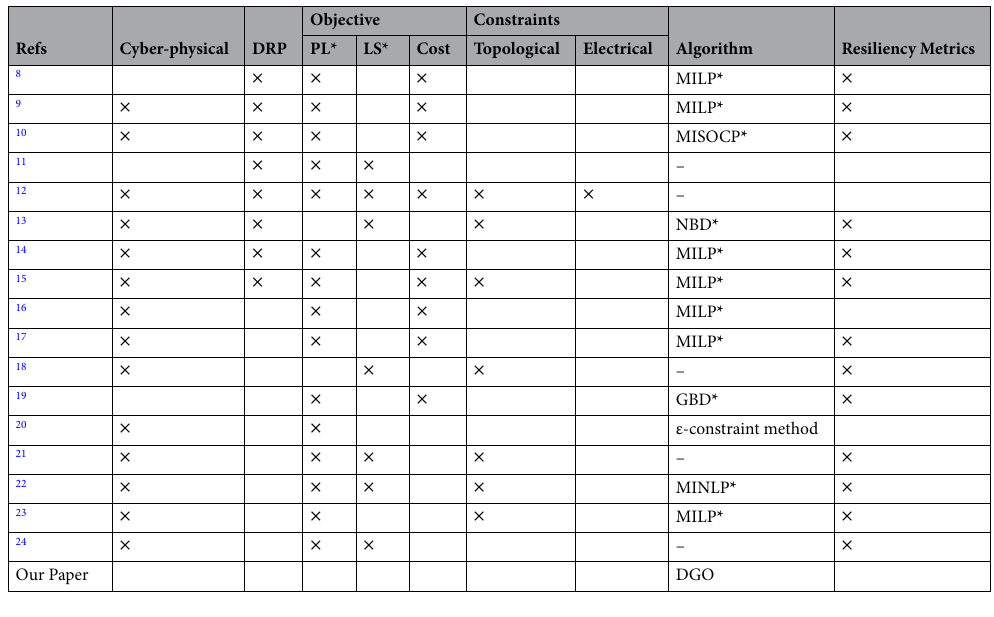
Table 1. Classification of previous resilience studies regarding post-disaster MG